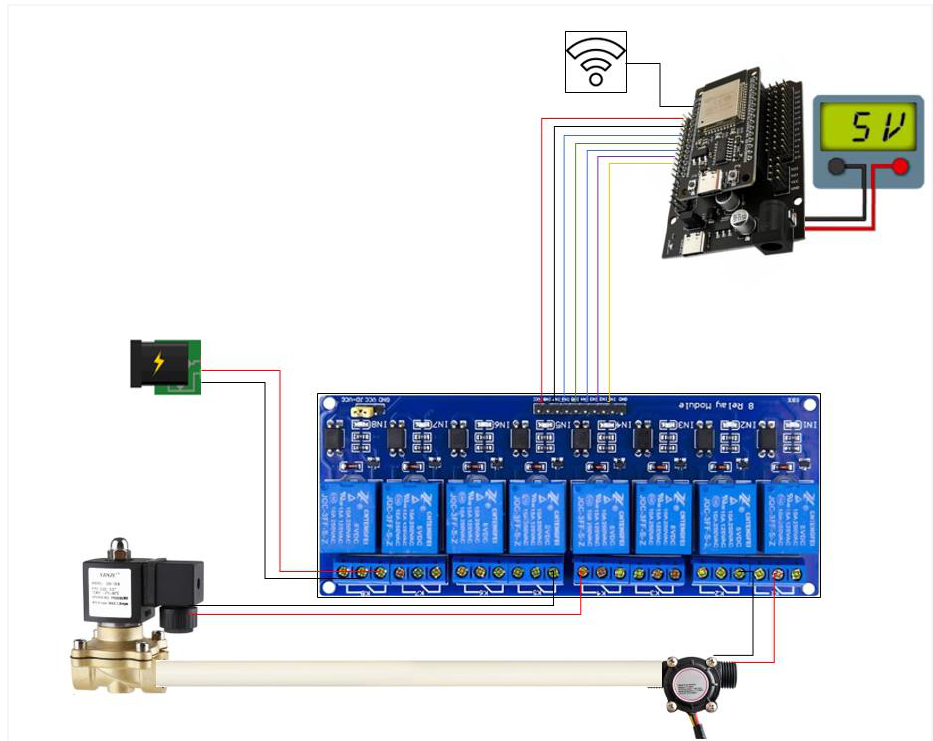
Figure 4. Model of the automated control system for the feeding of the system.